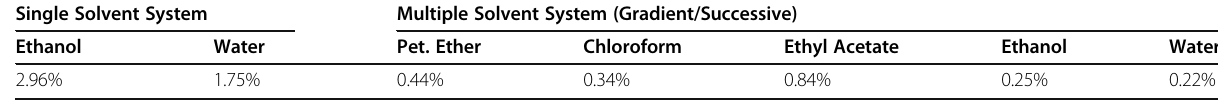
Table 4 Extraction yield of various solvents Single Solvent System